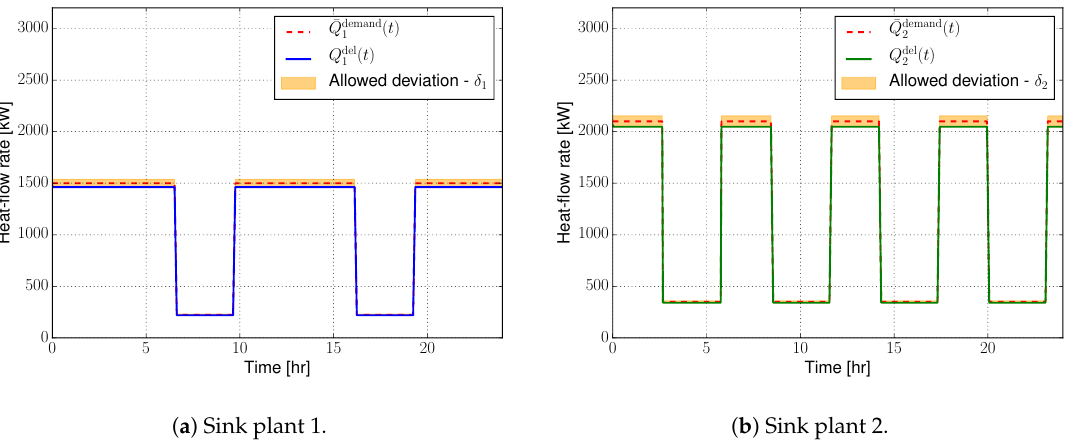
Figure 5. The heat-demands and the actual heat-flow rates into the sink plants for the industry cluster in Figure